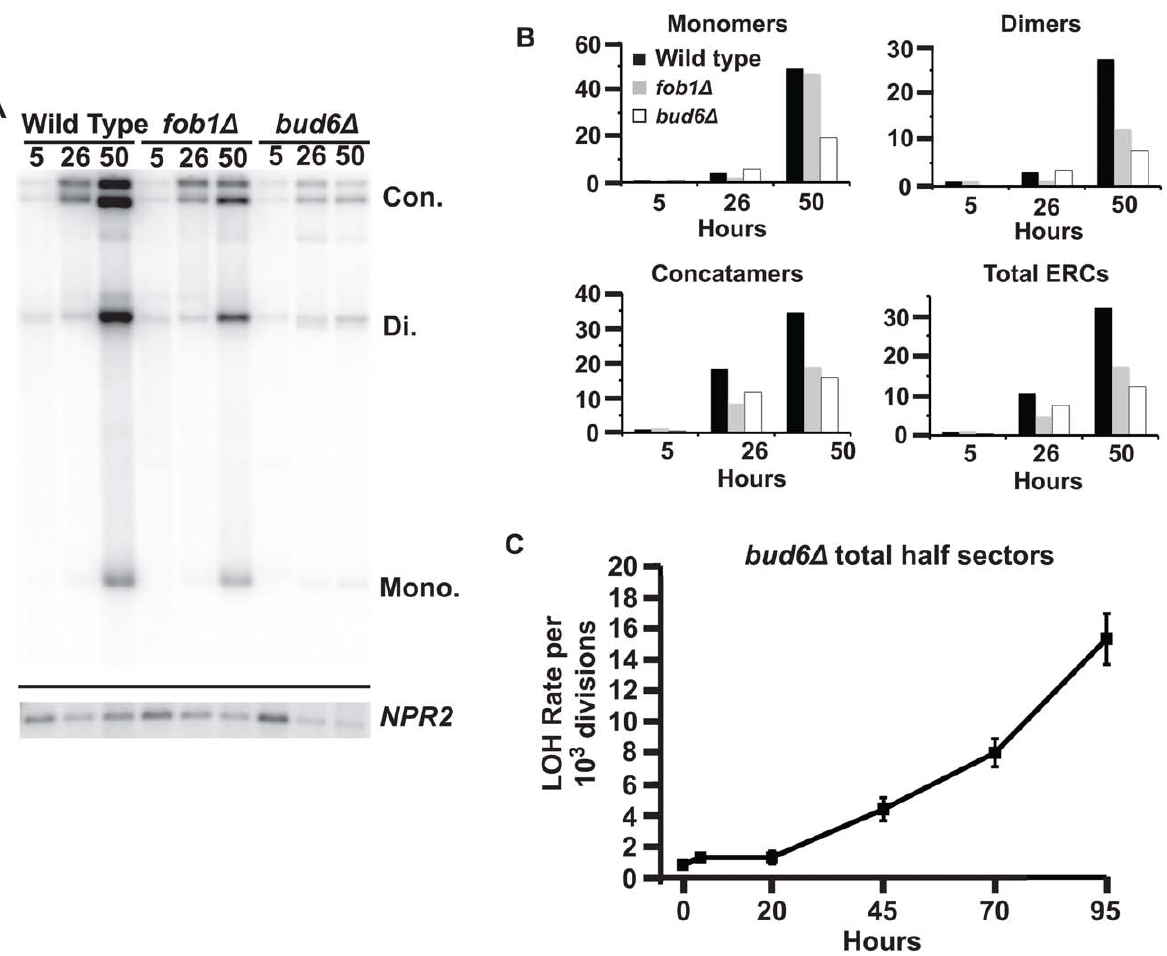
Figure 8. ERC accumulation in aging diploid cells. A) Southern blot of total genomic DNA isolated from aging populations and digested with Bam HI and RecBCD. Genotypes and replicative age in hours indicated at top. ERC species indicated at right: ERC Concatamers- Con.; Dimers- Di.; Monomers- Mono. Mean bud scar counts at 26 hours: WT =15.3 fob1 D =15.6, bud6 D =12.9. Lower panel: Southern blot of total genomic DNA isolated from aging cell populations, digested with BamHI and probed for NPR2 . B) ERC levels normalized to NPR2 (panel A). For individual ERC species, wild type 5-hour lanes are set as 1x fold. Total ERCs were calculated as the sum of the integrated density of each ERC species, with the wild type 5-hour lane set as 1x fold. C) Total LOH rates at MET15 in aging cultures of the bud6 D strain UCC8904. Error bars indicate